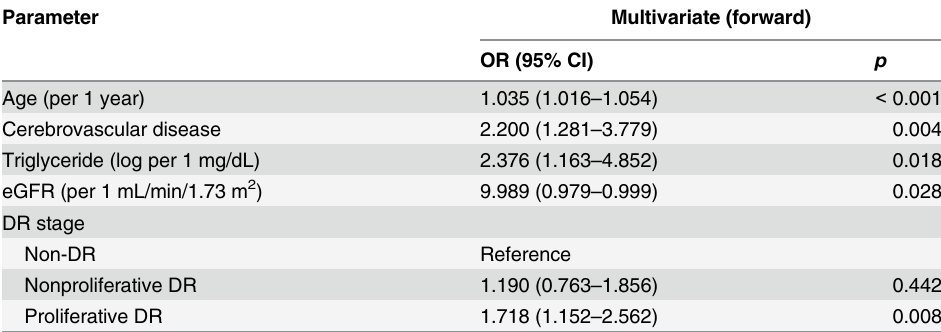
Table 2. Determinants of abnormal ABI using multivariate logistic regression analysis in total patients. Parameter